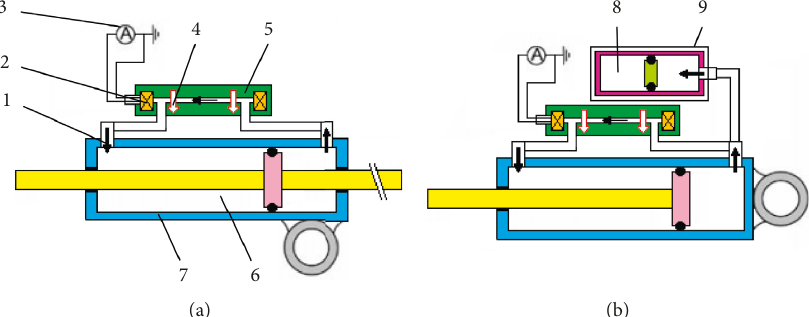
Figure 20: Schematic configurations of the proposed MR shock dampers: (a) double-ended MR shock damper and (b) single-ended MR shock damper. 1, MRF flow; 2, coil; 3, current source; 4, magnetic field; 5, MR valve; 6, MRF; 7, cylinder; 8, gas chamber; 9, piston-type accumulator [68].